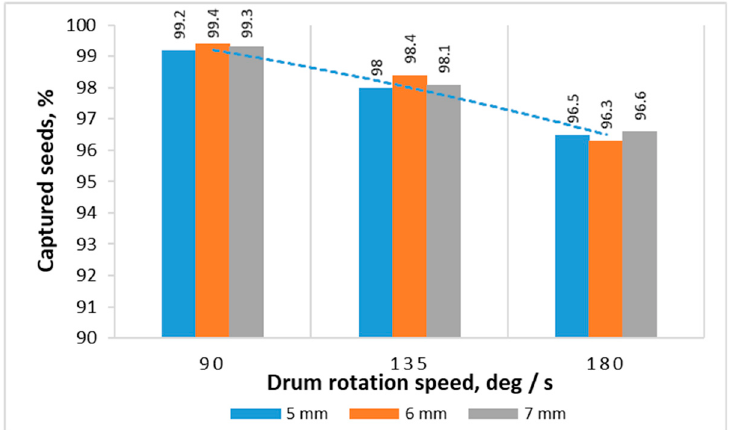
Figure 17. Sowing uniformity.